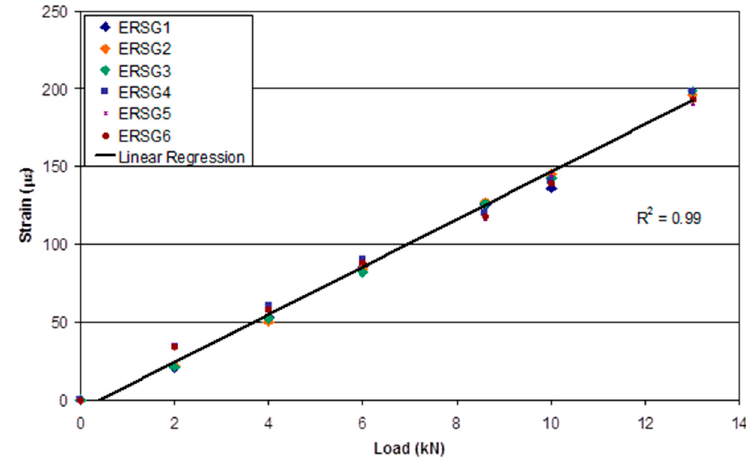
Figure 15. Strain measured on the steel plate via the surface-bonded ERSGs as a function of the applied load measured by the load-cell of the pre-stressing rig.